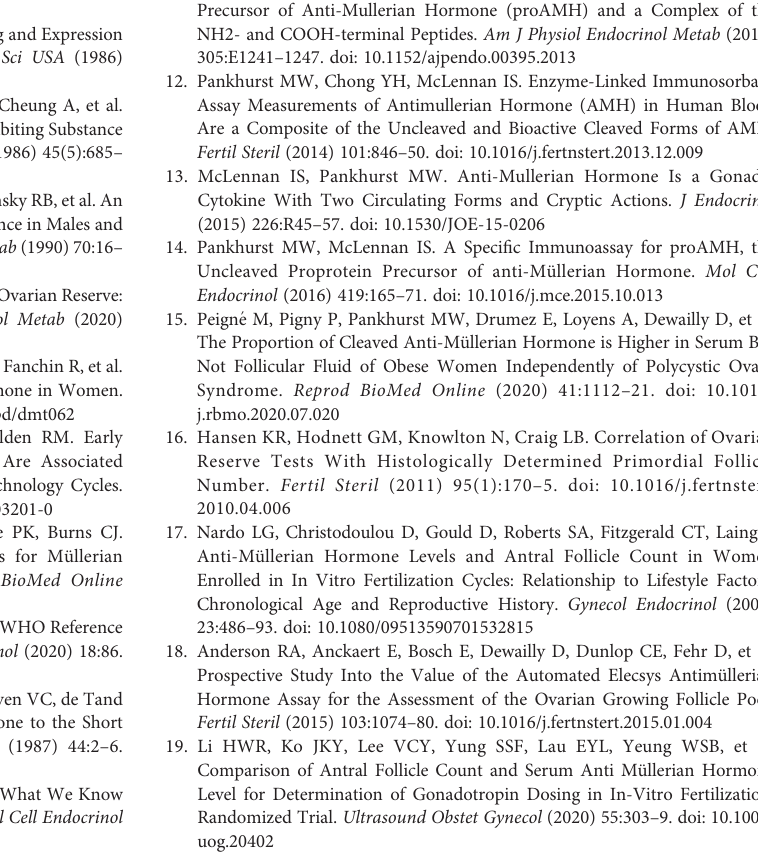
Supplementary Figure 1 | Multiple forms of AMH generated by post-translation cleavage. The amino acid sequence is numbered from the N-terminus of the pre-proAMH in this fi gure. The proAMH molecule itself contains 230 amino acid residues. Supplementary Figure 2 | Correlation between the Beckman-Coulter Gen II assay (Gen II), Access AMH assay (Access), and Elecsys AMH Immunoassay (Roche) for determination of AMH (n=94). The upper panels represent the Passing and Bablok regression plots whereas the lower panels represent the Bland-Altman plots. (Reproduced with permission from Li et al., 2016)